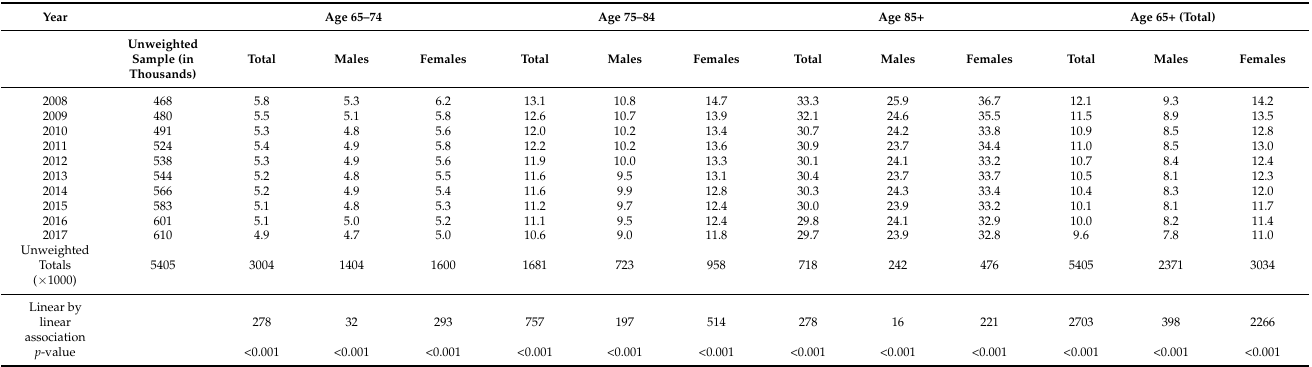
Table 1. Temporal trends in the prevalence of activities of daily living (ADL 1 ) limitations by decade (2008–2017), gender, and age cohort (ages 65–74; 75–84; 85+; full sample aged 65 and older). Source: American Community Surveys Data (n = 5405,135). (The prevalences are weighted; the sample sizes are unweighted and provided in thousands).